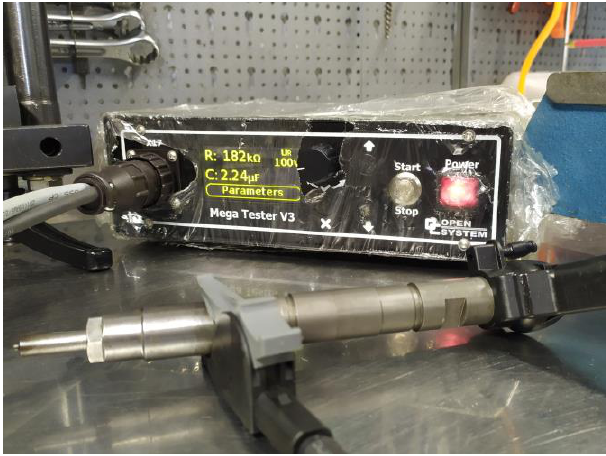
Fig. 4. Testing piezoelectric actuator with the Mega Tester